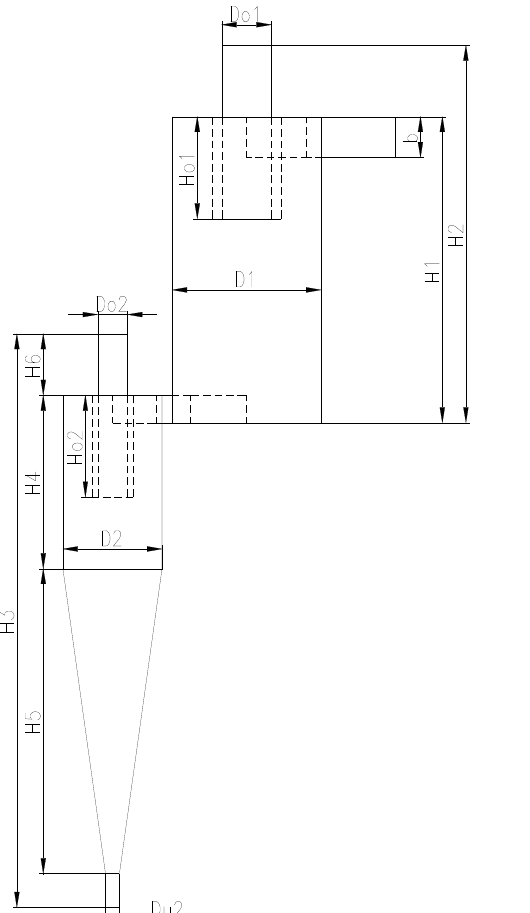
Figure 1. Two-stage (TS) hydrocyclone.